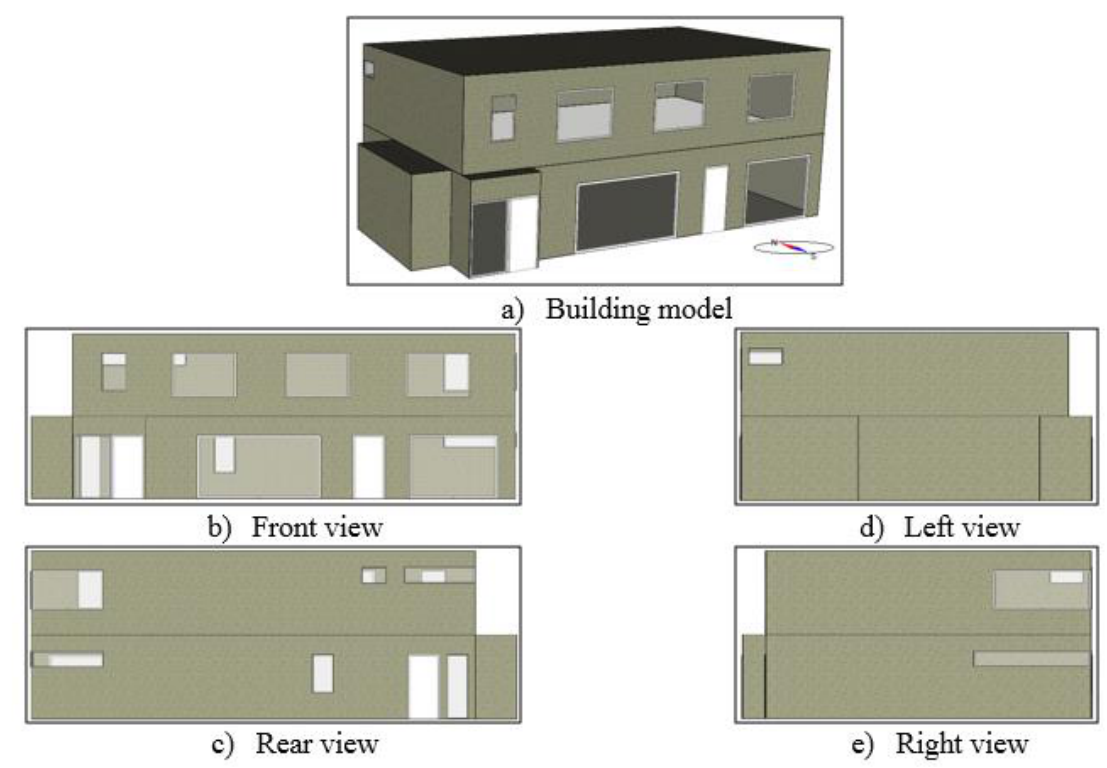
Figure 3. ( a ) Building model and views of ( b ) Front, ( c ) Rear, ( d ) Left, ( e ) Table 1. A detailed description of input data for a reference building model.